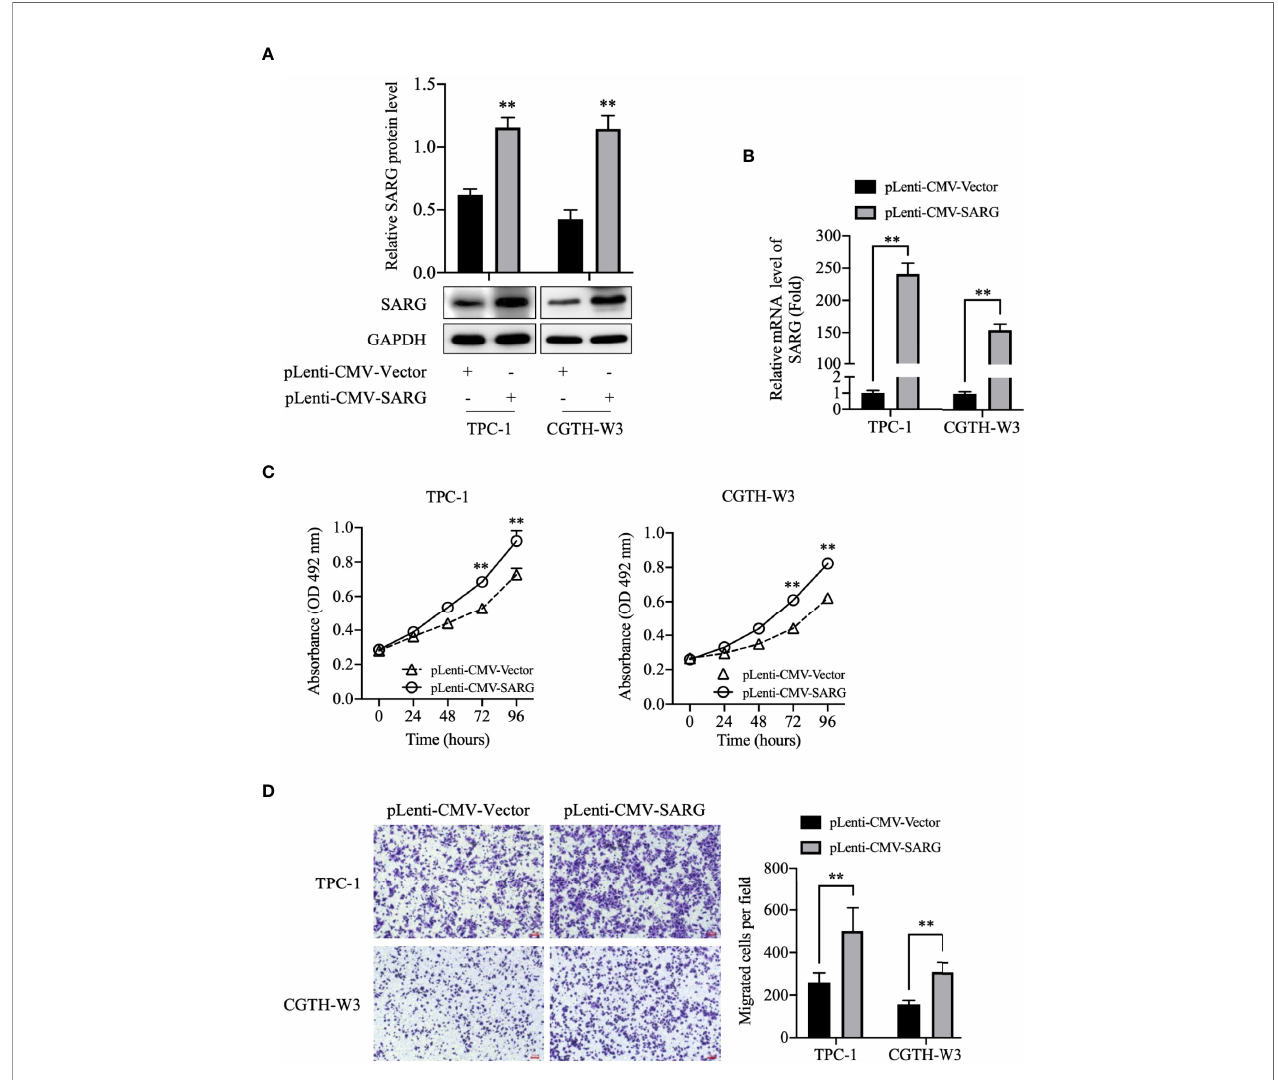
FIGURE 3 | SARG overexpression promoted PTC cells proliferation and migration. (A) SARG protein expression in TPC-1 and CGTH-W3 cells was signi fi cantly increased after being transfected with pLenti-CMV-SARG plasmid. GAPDH was used as a loading control, whereas pLenti-CMV-vector was used as the negative control. (B) SARG overexpression ef fi ciency was evaluated by reverse transcription-quantitative PCR, with all expression levels normalized to those of GAPDH. Data are presented as fold changes relative to the SARG levels in control cells. (C) SARG overexpression could increase TPC-1 and CGTH-W3 cells proliferation. (D) SARG overexpression promoted TPC-1 and CGTH-W3 cells migration in transwell assay. SARG, speci fi cally androgen-regulated gene. **, p<0.01